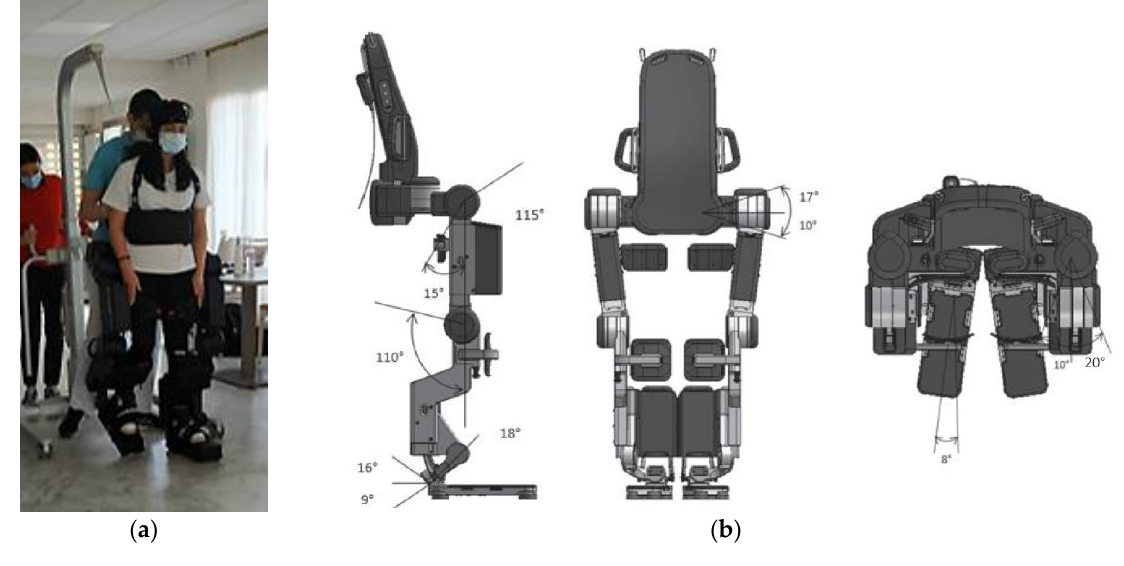
Figure 1. Atalante ® exoskeleton (Wandercraft company, Paris, France). ( a ) Participant using the exoskeleton Atalante ® ; ( b ) mechanical design with ranges of motion.